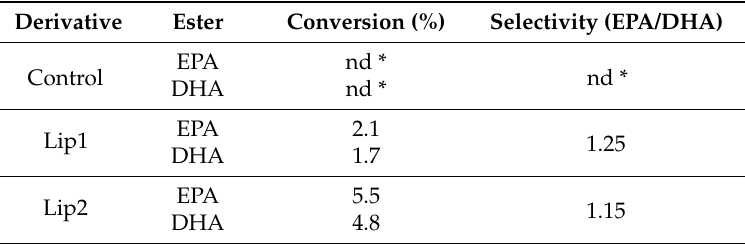
Table 6. Ethanolysis of sardine oil catalyzed by F. verticillioides lipases adsorbed to octadecyl Sepabeads in cyclohexane.